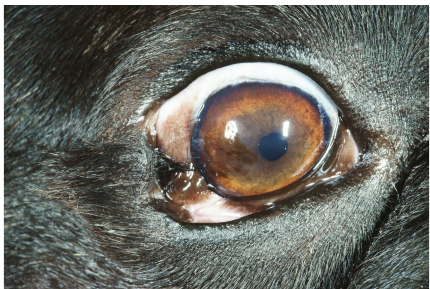
Figure 3: Case 2 appearance at initial presentation. Abnormal haired tissue is present in the lateral canthus OD and affects both the cutaneous and conjunctival aspects of the eyelid. Corneal pigmen- tation is also present.